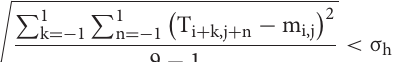
are constituted by deep convection clouds (Cb or Cu cong) with the flat top (the so-called anvil) that reaches the tropopause. In the high BT region (290–300 K) these scenes are represented by the equatorial ocean surface patches with no clouds above. The calibration in the medium BT range is carried out with using the stratus clouds of the first (stratus, St) and second (altostratus, As)